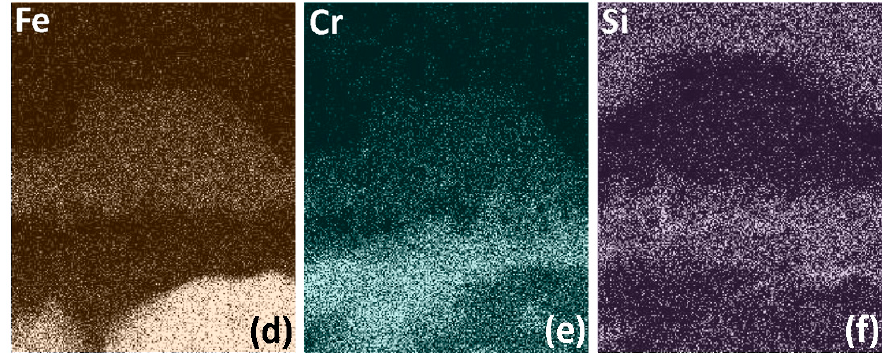
Figure 11. ( a ) High-angle annular dark-field (HAADF) STEM image of LNO-M-800 sample. ( b–f ) EDX map of Ni, O, Fe, Cr, and Si elements, respectively.